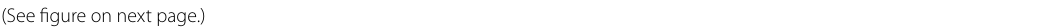
figure on next page.) Fig. 3 A 53-year-old patient presented with right breast lump. a and b DM in CC and MLO views showed UIQ irregular mass and maximum dimension of 3.6 cm. c 2D US revealed a spiculated mass lesion with marked desmoplastic reaction and maximum dimension of 2.1 cm. d 3D US revealed spiculated lesion and maximum dimension of 2.7 cm. e and f DBT in CC and MLO views revealed spiculated lesion and maximum dimension of 4 cm. g and h CESM revealed heterogeneously enhancing mass lesion and maximum dimension of 2.7 cm. Postoperative pathology revealed a single tumor, IDC, with maximum dimension of 2.5